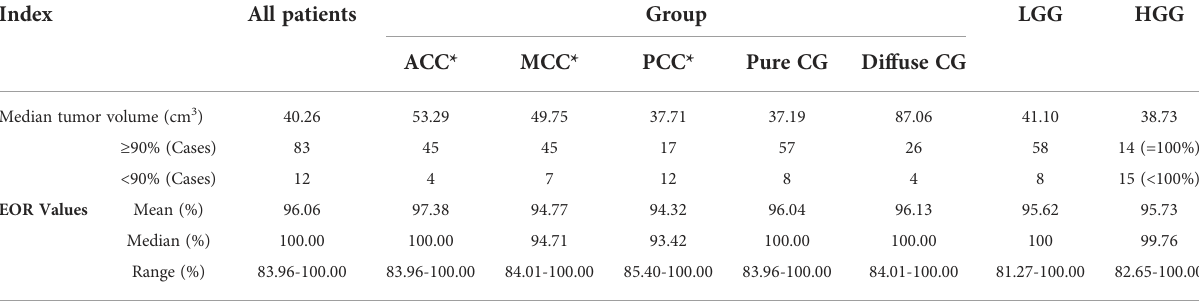
TABLE 2 Summary of tumor volume and EOR (extent of resection) in 95